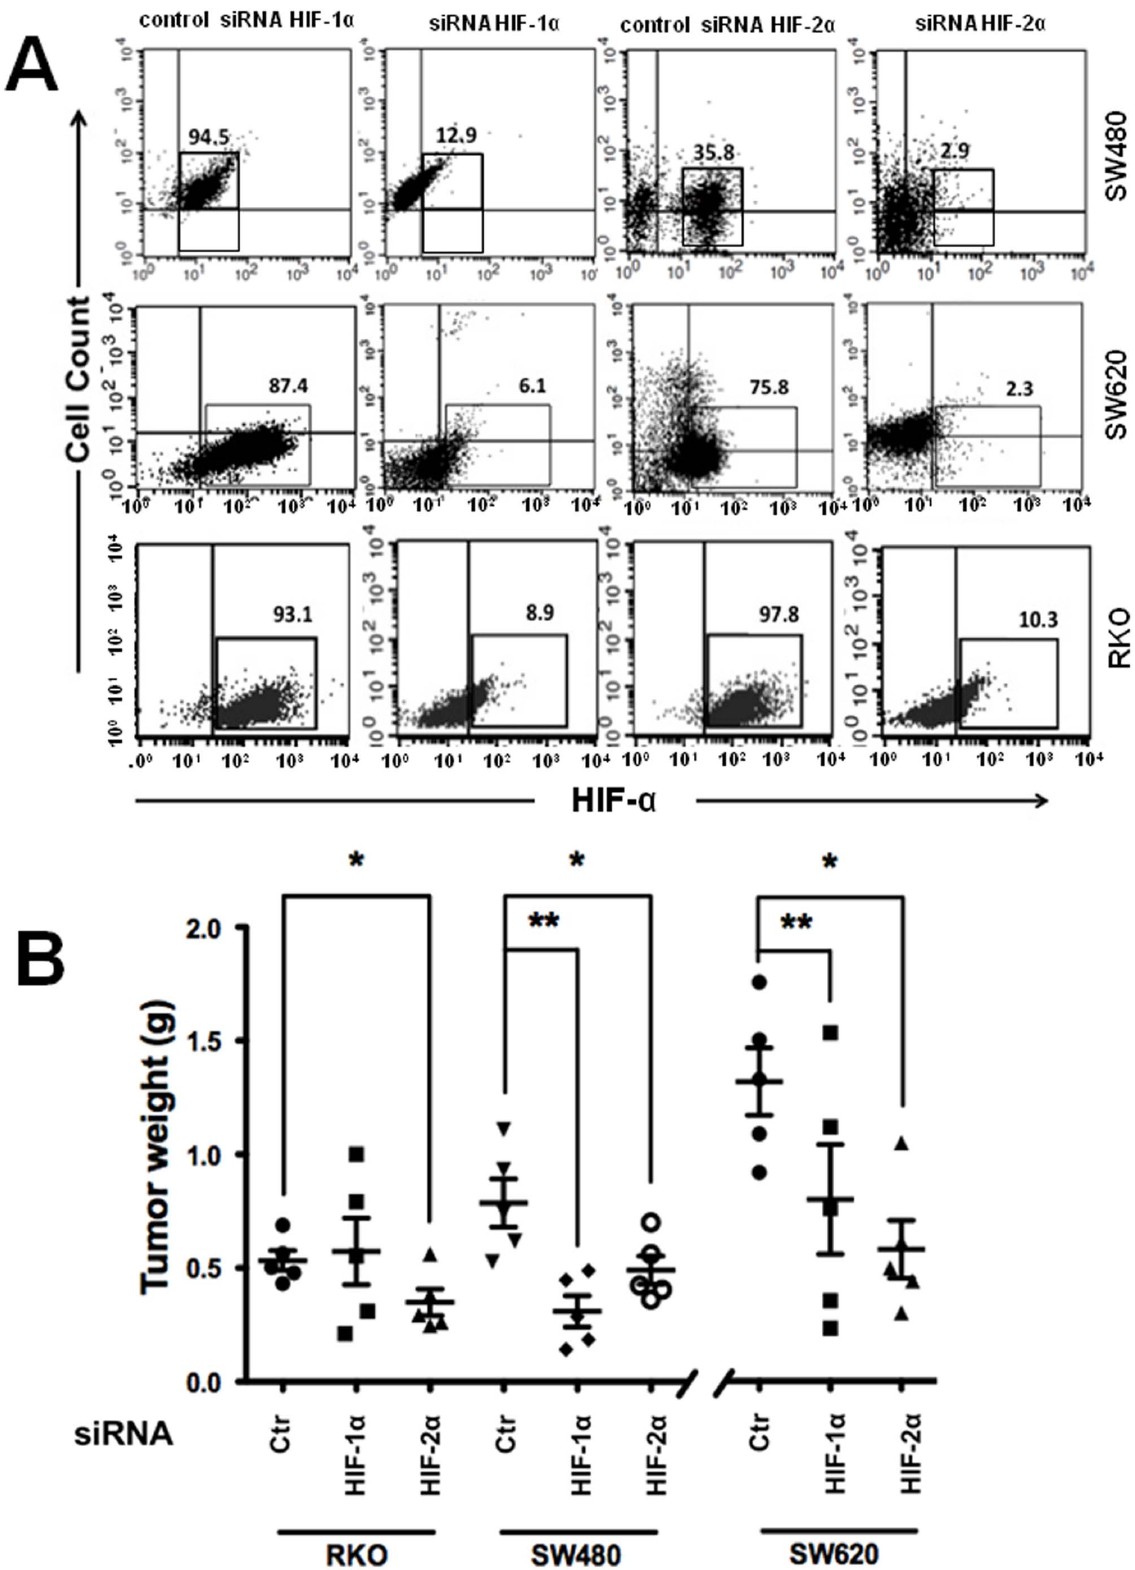
Figure 5. Stable silencing of HIF-1 a or HIF-2 a decreased the invivo tumorigenic activity of engrafted colon cancer cells. A) Stable HIF- 1 a - or HIF-2 a -knockdown or control transfectants were obtained as described in the ‘‘Materials and Methods’’ from the RKO, SW480, and SW620 colon cell lines. Selected clones were screened by flow cytometry to determine the silencing of HIF-1 a and HIF-2 a in comparison with the control cells. B) A total of 1 6 10 6 stable control (Ctr in the figure) or HIF-1 a - or HIF-2 a -silenced RKO, SW480, or SW620 cells were s.c. injected into the dorsal